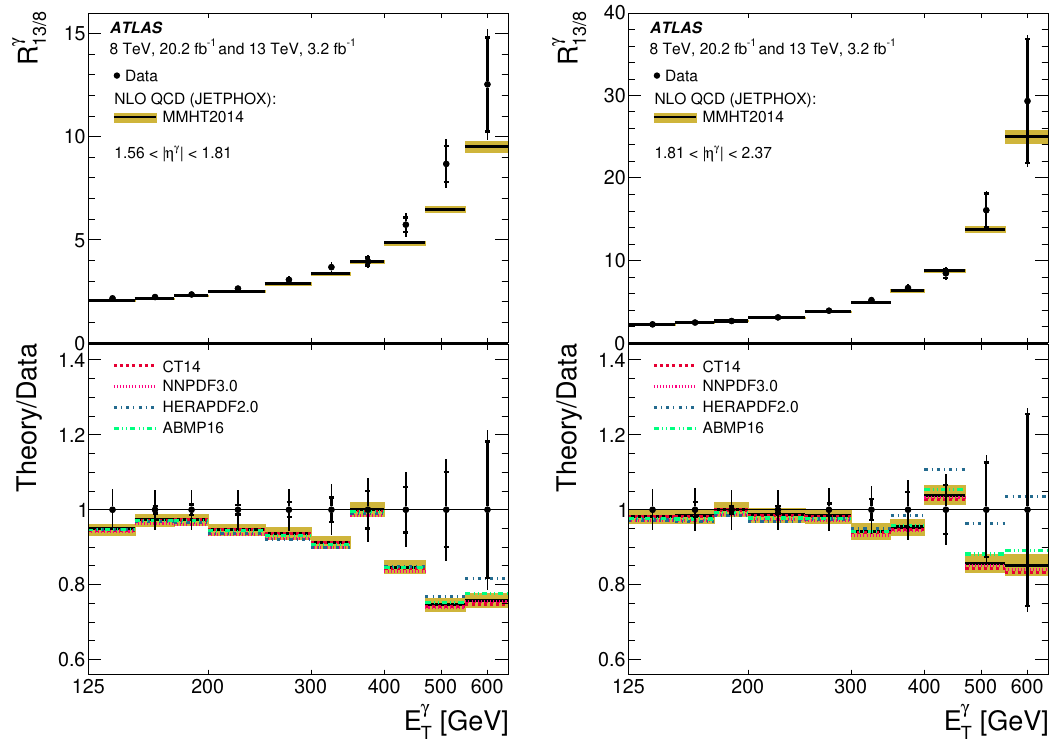
Figure 7 . The measured R (cid:13) (dots) as a function of E (cid:13) in di(cid:11)erent regions of j (cid:17) (cid:13) j . The NLO T 13 = 8 QCD predictions based on the MMHT2014 PDFs (black lines) are also shown. The inner (outer) error bars represent the statistical (total) uncertainties. The shaded band represents the theoretical uncertainty in the predictions. For most of the points, the error bars are smaller than the marker size and, thus, not visible. The lower part of the (cid:12)gures shows the ratio of the NLO QCD predictions based on the MMHT2014 PDFs to the measured R (cid:13) (black lines). The ratios of the NLO QCD 13 = 8 predictions based on di(cid:11)erent PDF sets to the measured R (cid:13) are also included. 13 = 8